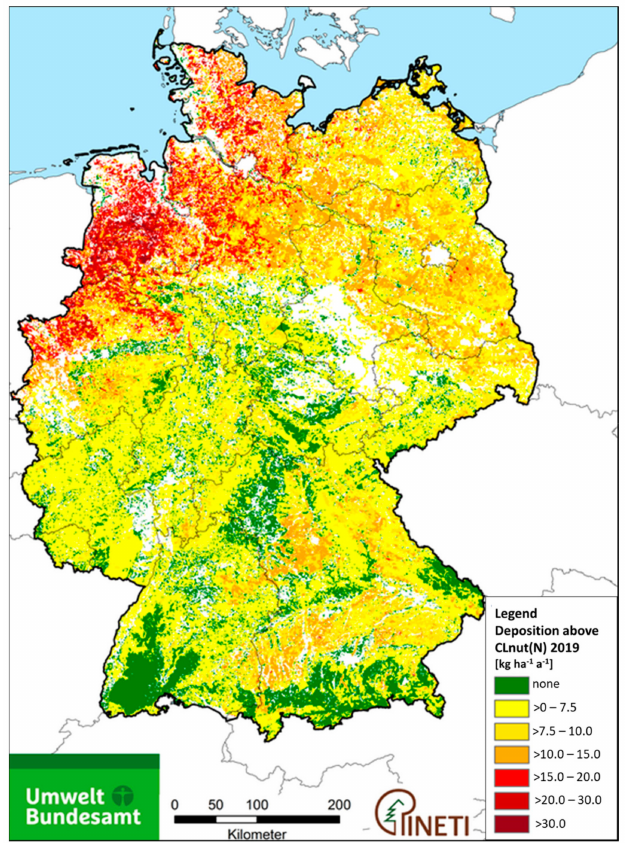
Figure 8. Exceedance of the CL for eutrophication due to nitrogen deposition for the year 2019. Source: